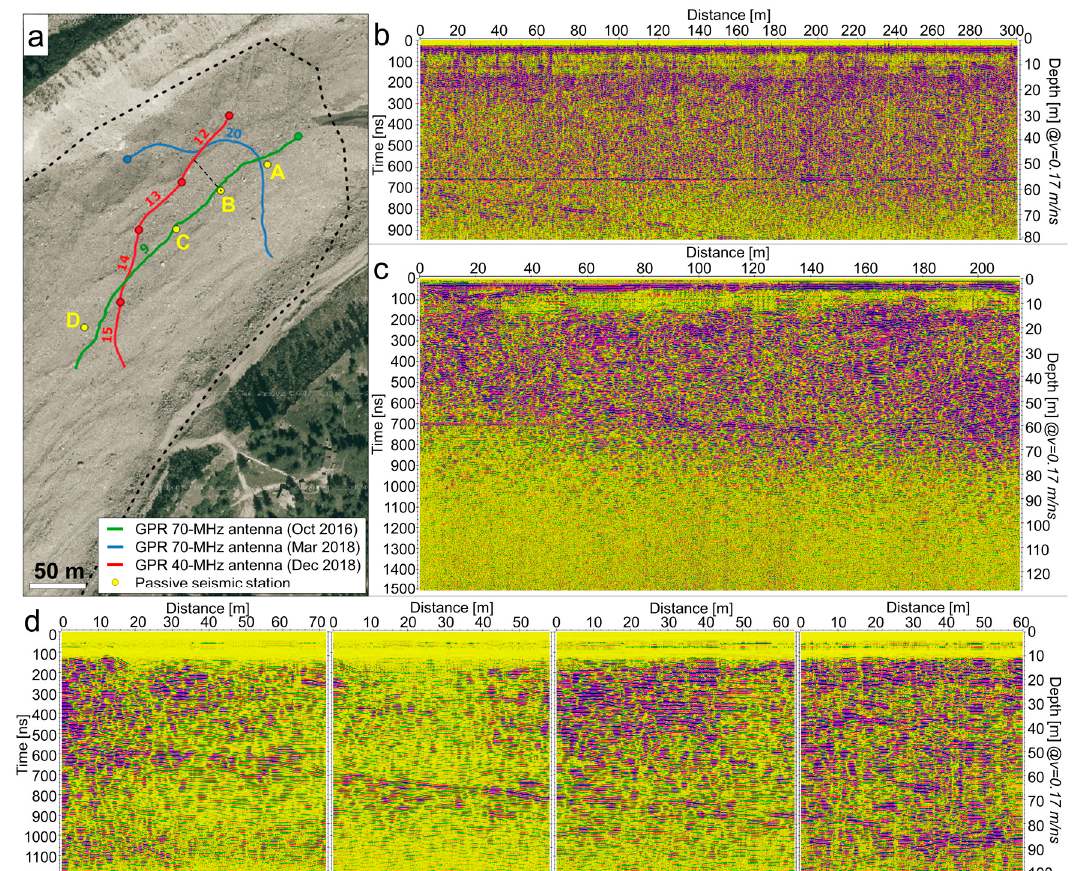
Figure 4. GPR results. ( a ) Location of the GPR profiles are shown in the right and bottom sections. The starting point of each profile is highlighted with a dot. ( b ) Profile 9 (70-MHz antenna, October 2016). ( c ) Profile 20 (70-MHz antenna, March 2018). ( d ) Profile 12 to 15 (left to right, 40-MHz antenna, December 2018). The vertical scale of some radargram is cut (no reflections for higher recorded times).